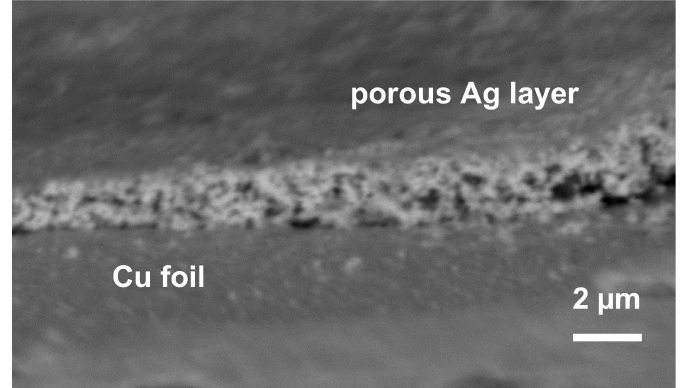
Figure 4. The interface between the copper foil and the porous silver layer formed in situ in a model SPS experiment (SEM image). For conditions of the experiment, refer to the